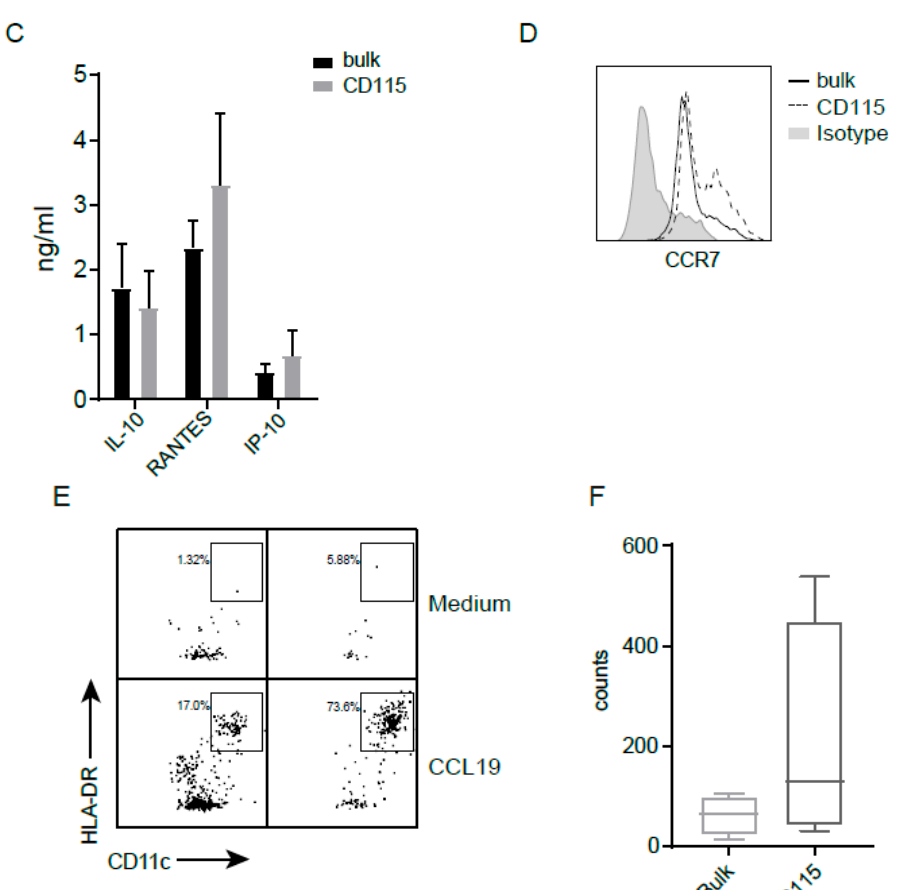
Figure 3. Maturation and migration by CD115-DCs. For flow cytometry analysis, live cells were gated with SSC/FSC, followed by doublet exclusion based on FSC-W/FSC-A. ( A ) Percentages of DCs (HLA-DR+CD11c+) and CD83 at the end of differentiation (day 14) and after an additional 24 h of maturation with cytomix. ( B ) Expression of CD40, CD80, HLA-ABC, and PD-L1 on DCs (live/single/CD11c+HLA-DR+) from the standard (black line) compared to the CD115 culture (dotted line), with an isotype as control (grey). ( C ) Cytokines (IL-10, RANTES, and IP-10) produced by standard or CD115 culture after 24 h of maturation. ( D ) Expression of CCR7 on DCs (live/single/CD11c+HLA-DR+) from the standard (black line) compared to the CD115 culture (dotted line), with an isotype as control (grey). ( E ) Representative migration assay towards CCL19 or medium as a control with DCs from either the bulk or the CD115 culture. ( F ) Quantification of migration with four different donors. Count of migrated mature DCs is shown. When indicated, significance was assessed using two-way ANOVA followed by Kruskal–Wallis multiple comparison (* p < 0.05).